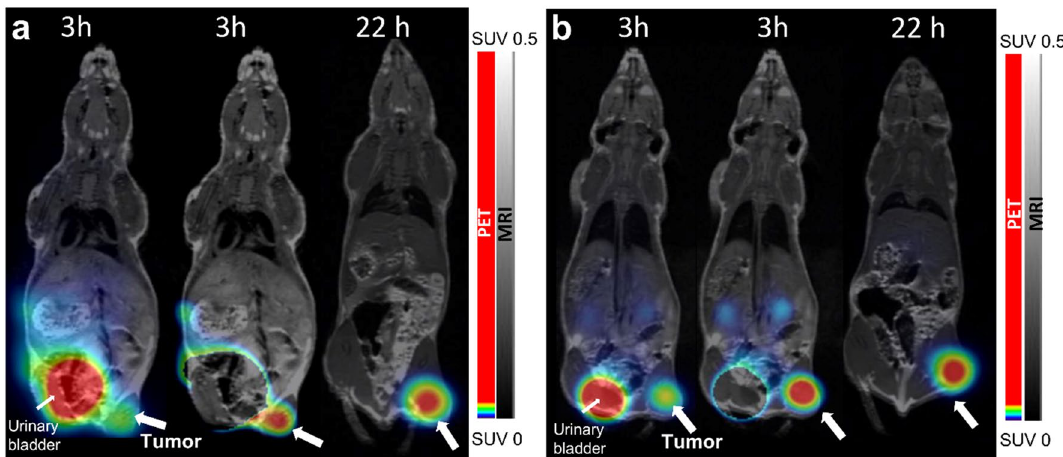
Figure 5. microPET/MR scans of PC-3 xenograft bearing mice at 3 h and 22 h pi. (a,b) show scans of two different animals injected intravenously with 40 pmol (0.25 MBq) [ 66 Ga]Ga-NOTA-PEG 2 -RM26 each. Mice were anaesthetized during the 3 h scan, and sacrificed before the 22 h pi scan. 3 h pi scans are displayed with a signal from urinary bladder (left) and with the signal from urinary bladder removed (middle) after